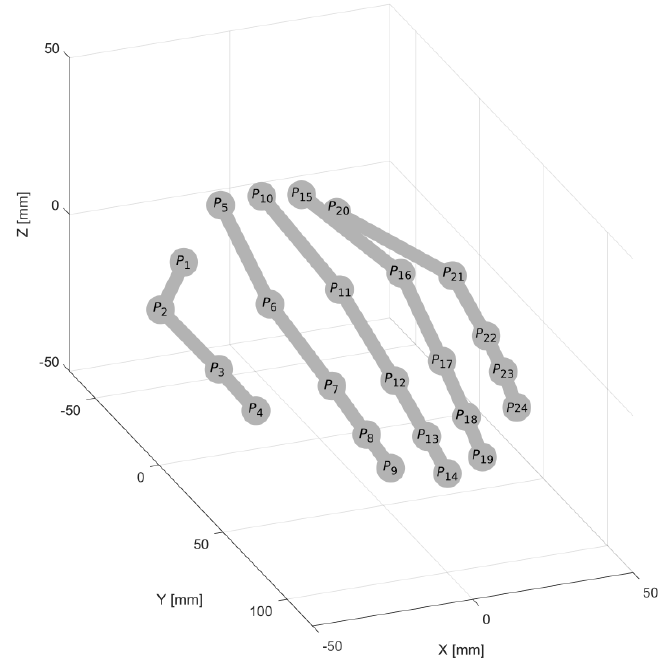
Figure 1. Hand skeletal